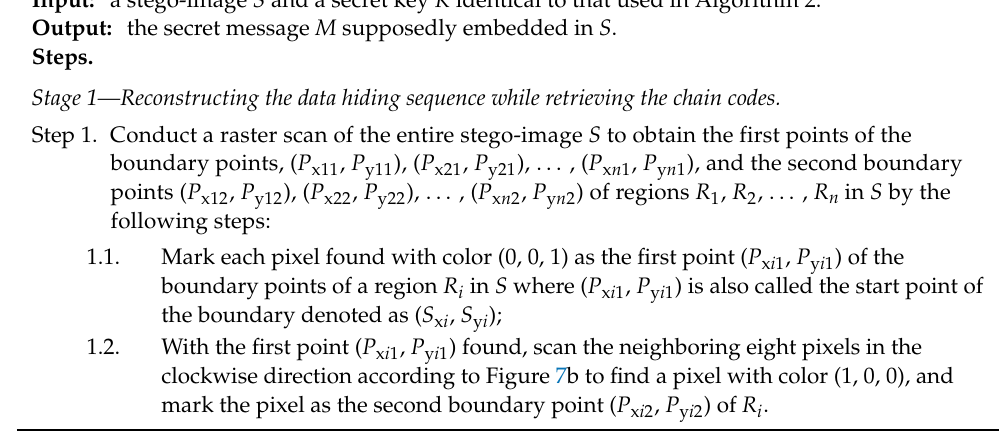
Algorithm 3. Extracting a secret message from a